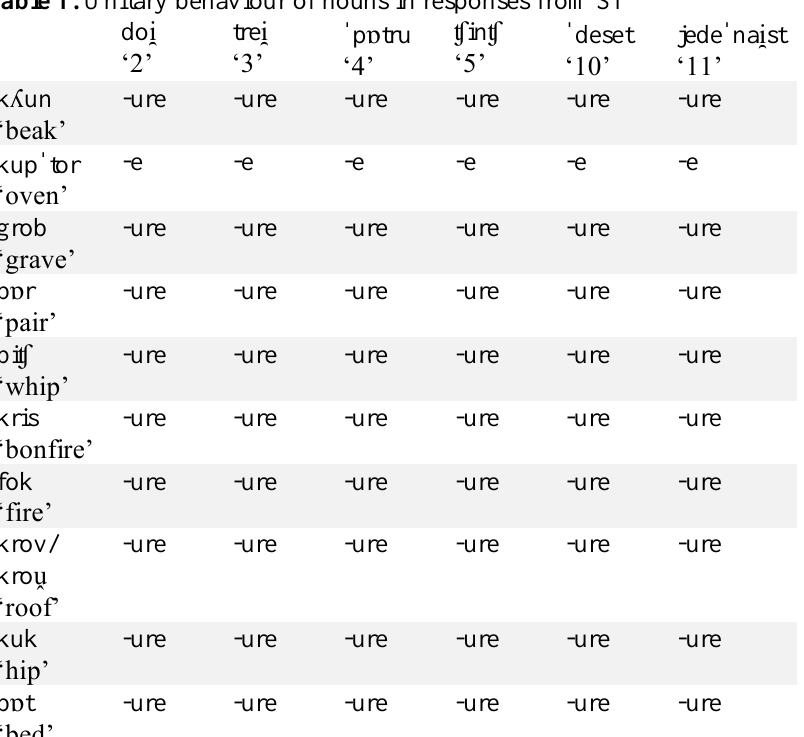
Table 1. Unitary behaviour of nouns in responses from